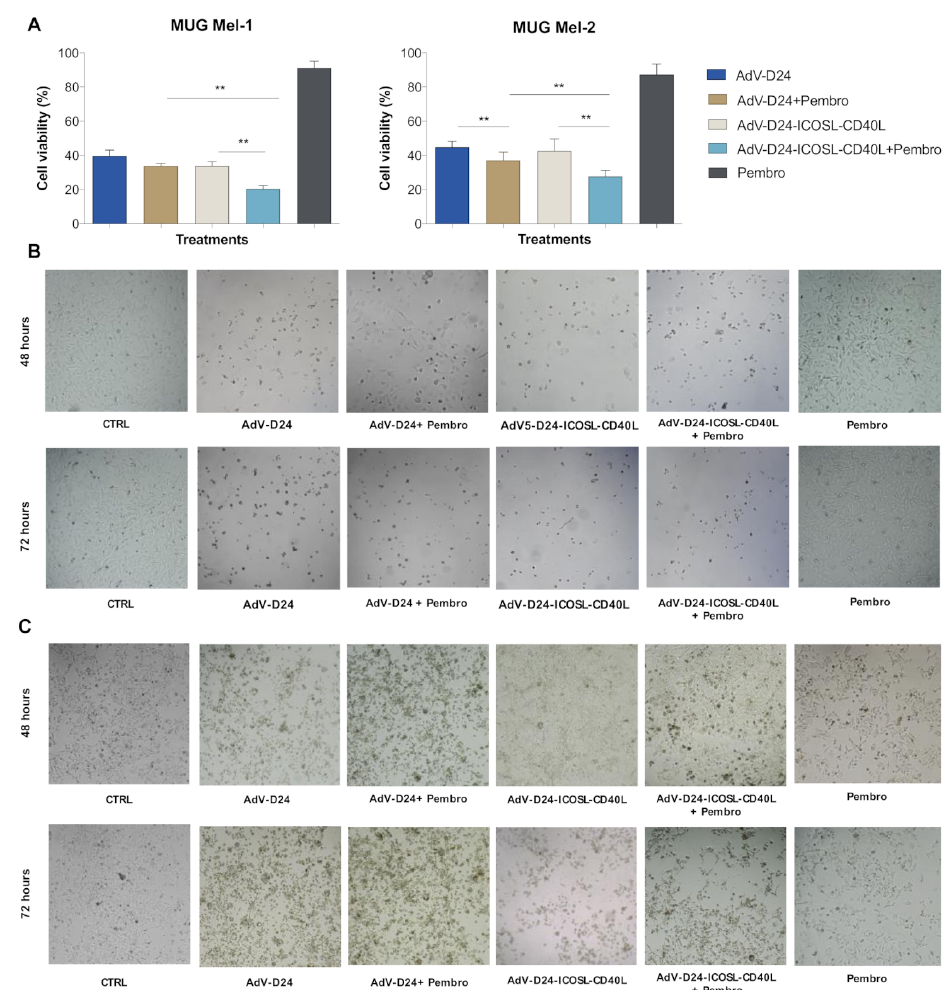
Figure 3. Evaluation of cell viability by MTS assay (cell cytotoxicity assay). ( A ) Cell viability was evaluated 72 h post-infection with AdV-24-ICOSL-CD40L and AdV-24 at the concentration of 100 VP/cell and combination with anti-PD1 (pembrolizumab). Data are expressed as the percentage of viable cells according to MTS cell viability assay protocol (CellTiter 96 ® AQueous One